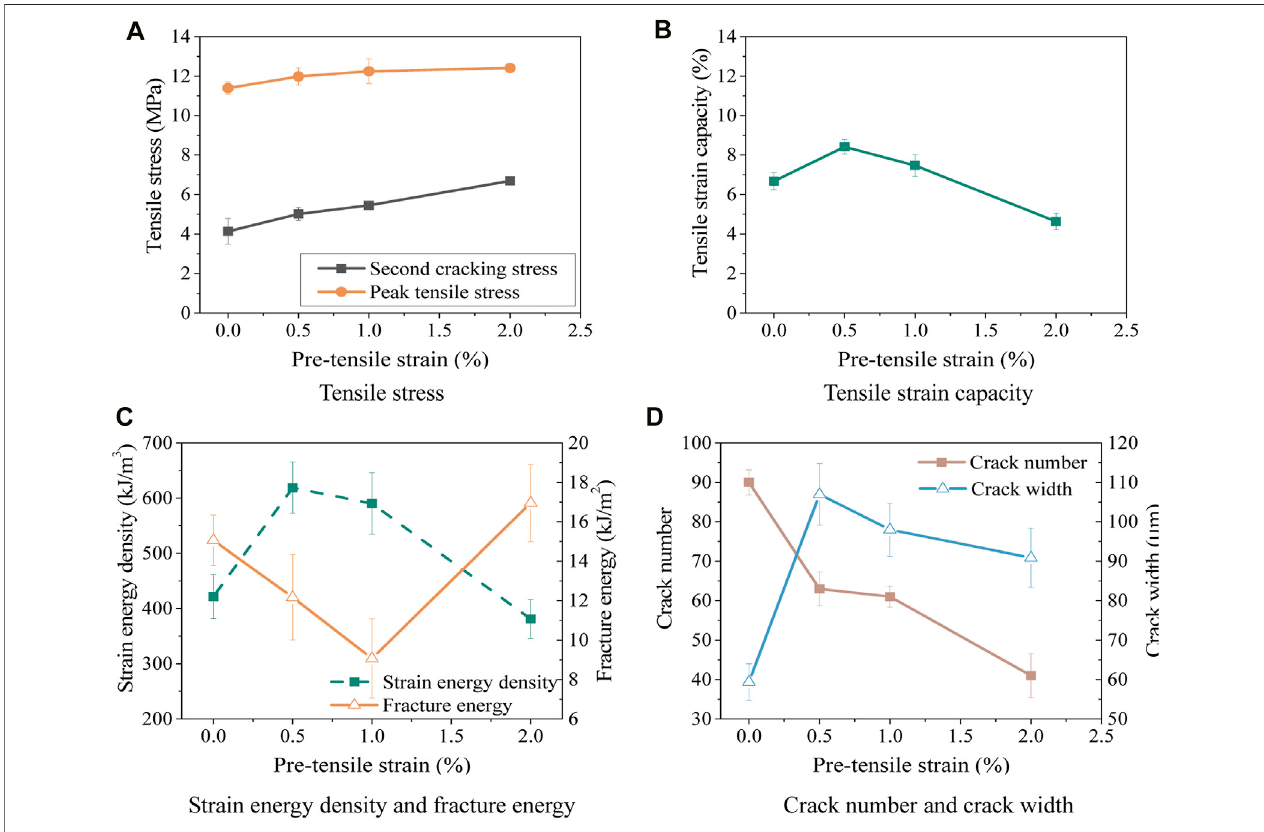
FIGURE 11 | Tensile parameters ofreloading CR2-0.4 specimens. (A) Tensile stress. (B) Tensile strain capacity. (C) Strain energy density and fracture energy. (D) Crack number and crack width.